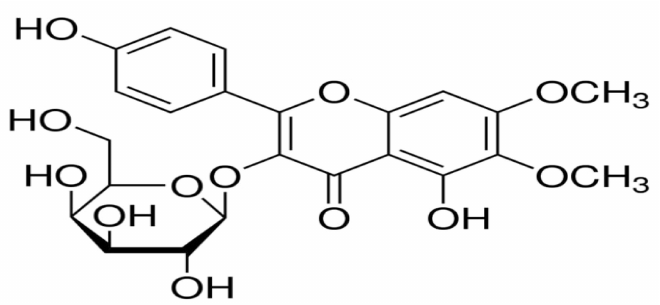
Figure 1. The chemical structure of eupalitin-3- O- β -D